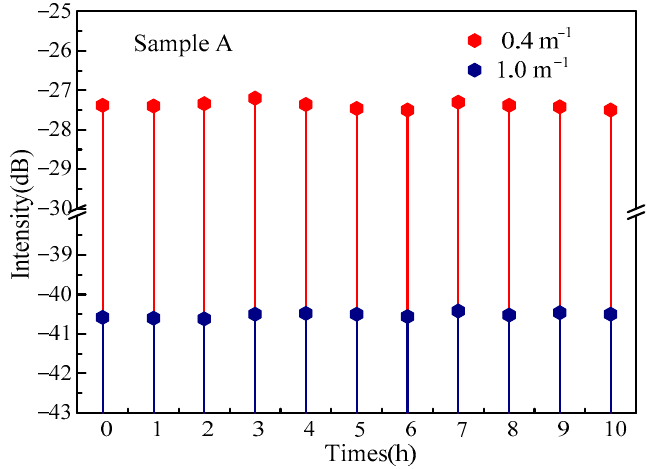
Figure 6. Bending stability test of sensor.